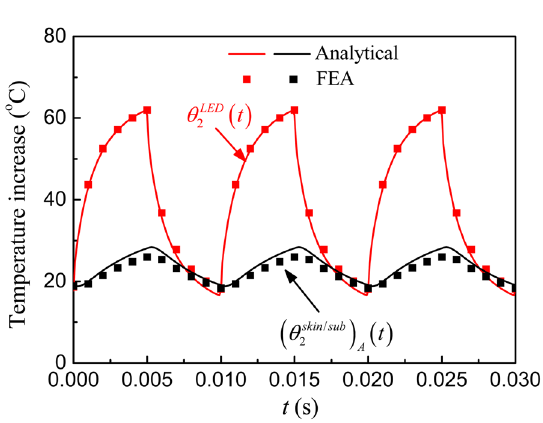
Figure 5. The μ -ILED temperature increase and the temperature increase at point A on the skin/substrate interface versus time under a pulsed power with the duty cycle 50% and period 10 ms for the thickness of substrate of 200 μ m.